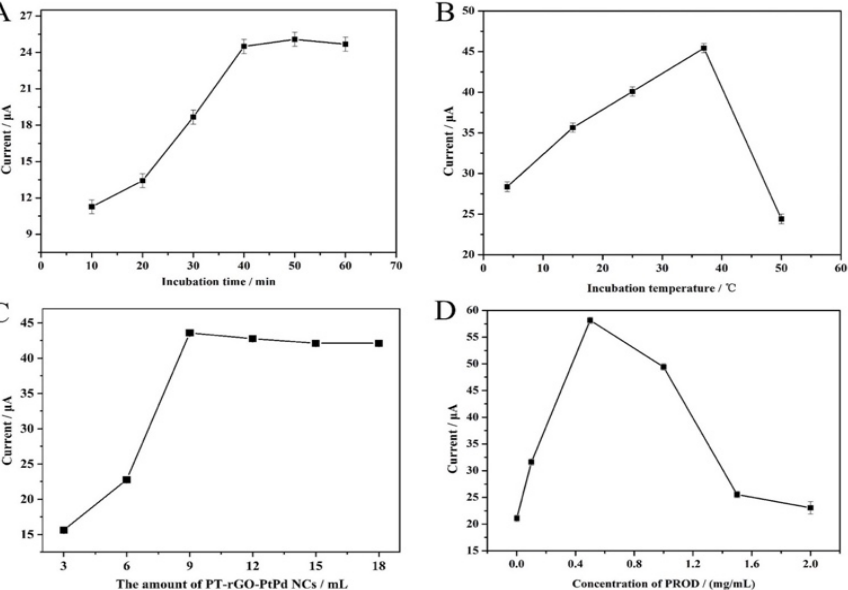
Figure 4. The optimization of experimental conditions. The effects of ( A ) different incubation times, ( B ) different incubation temperatures, ( C ) different amounts of PT-rGO-PtPd NCs, and ( D ) different concentrations of PROD on the response of the 1,5-AG biosensor were explored by the DPV method in PBS solution (0.1 mol/L, pH 7.0). The concentration of 1,5-AG in this experiment was set to 1.0 mg/mL. The error bars represent relative standard deviations (RSDs) ( n =